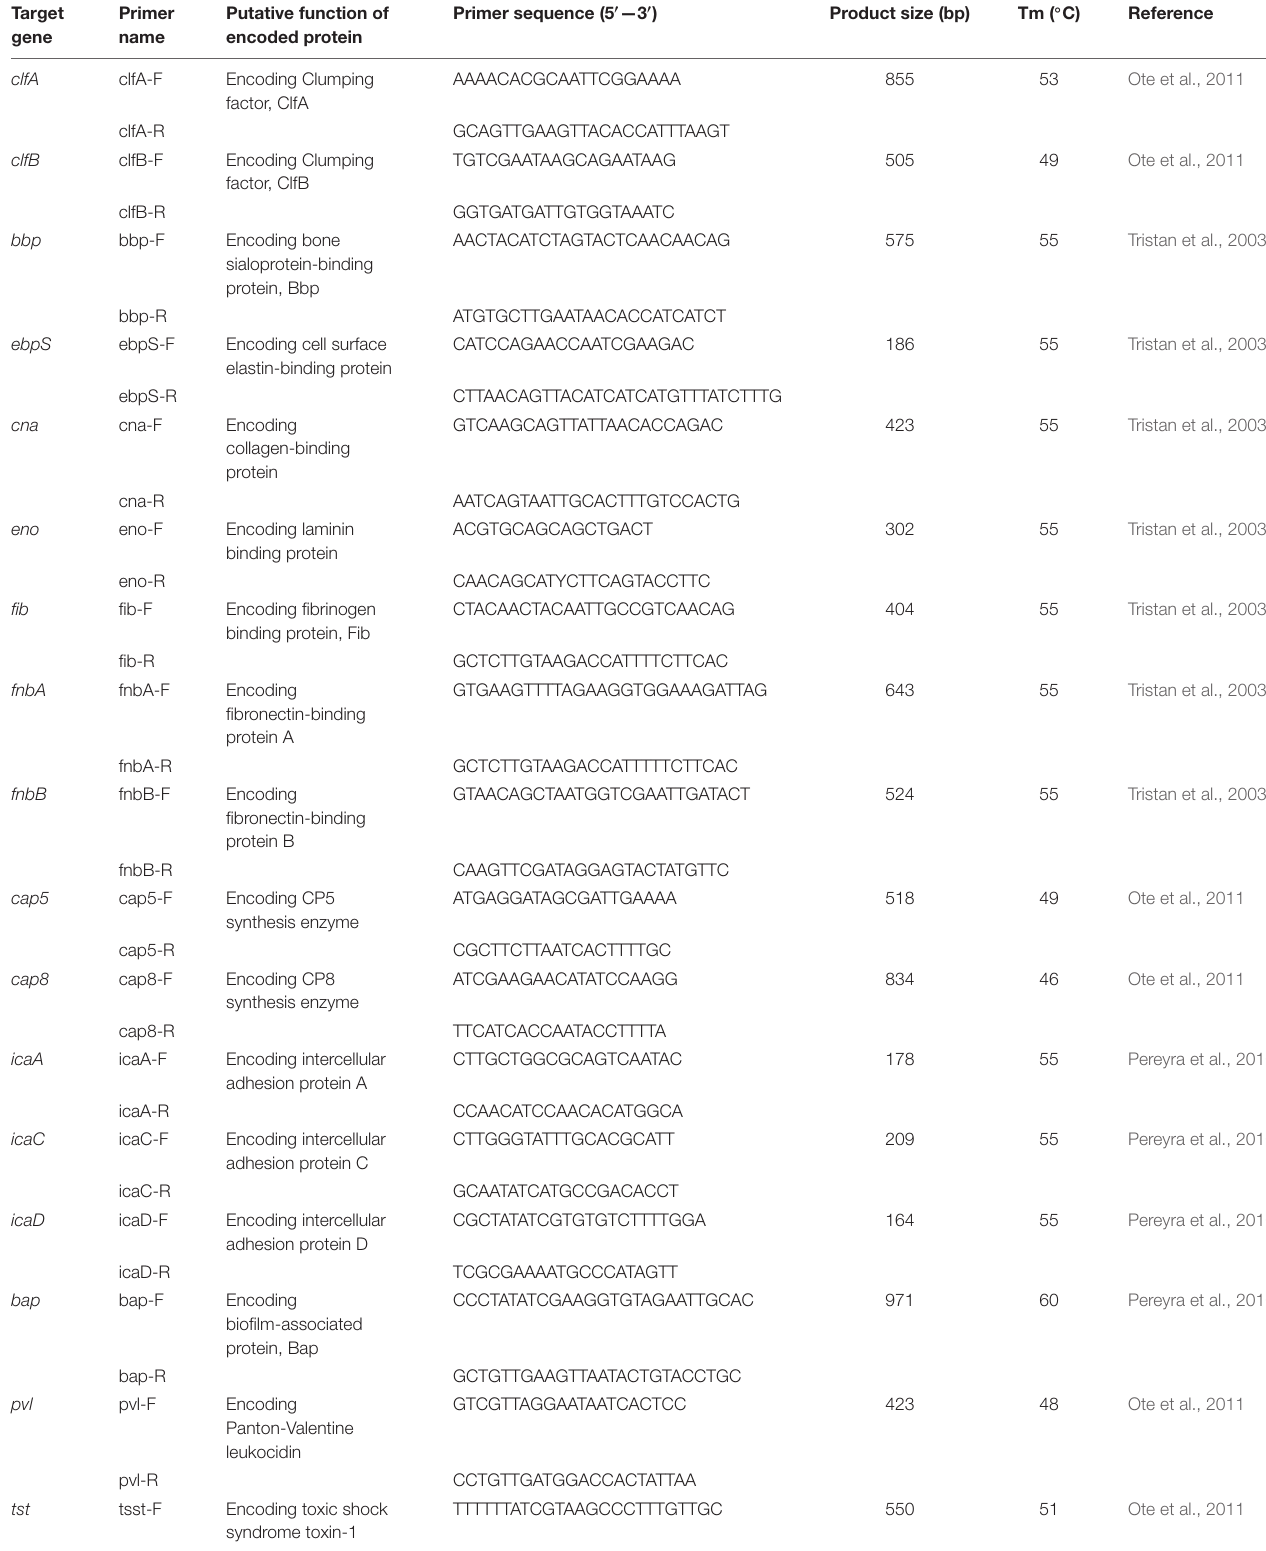
TABLE 1 | Target genes, putative function of encoded protein, primer sequence, and PCR conditions. Target